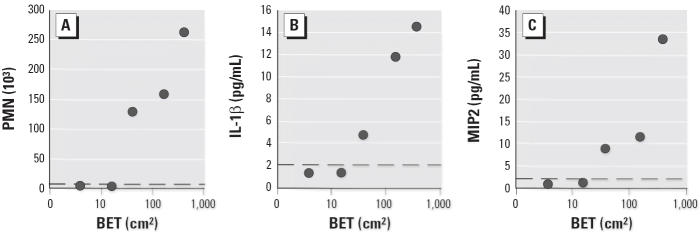
Threshold for inflammatory response for ufCP shown as the correlation between particle surface area and PMN cell numbers (A) or IL-1β (B) or MIP2 (C) concentrations. Two additional instilled doses of 0.5 and 2 μg, together with 5, 20, and 50 μg ufCP represent BET surface areas of 0.4, 16, 40, 161, and 404 cm2, respectively. The dashed line indicates baseline levels of control animals; each circle represents the mean of eight animals.